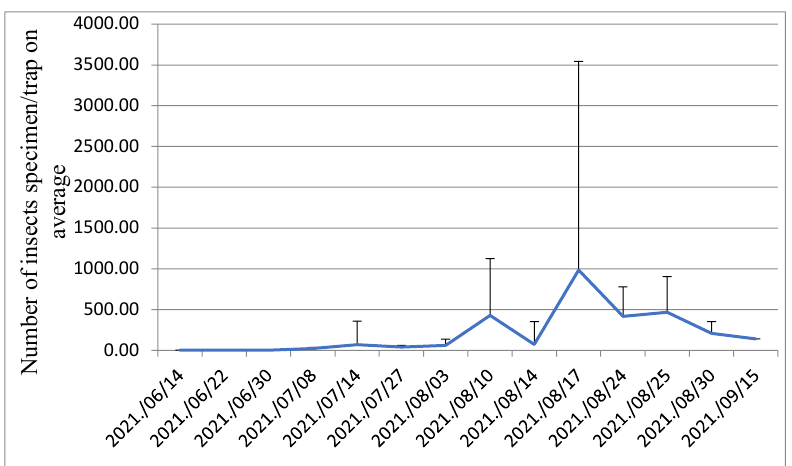
Figure 2. Summer dynamics of the cotton bollworm. Central zone of Krasnodar Krai. 2021.